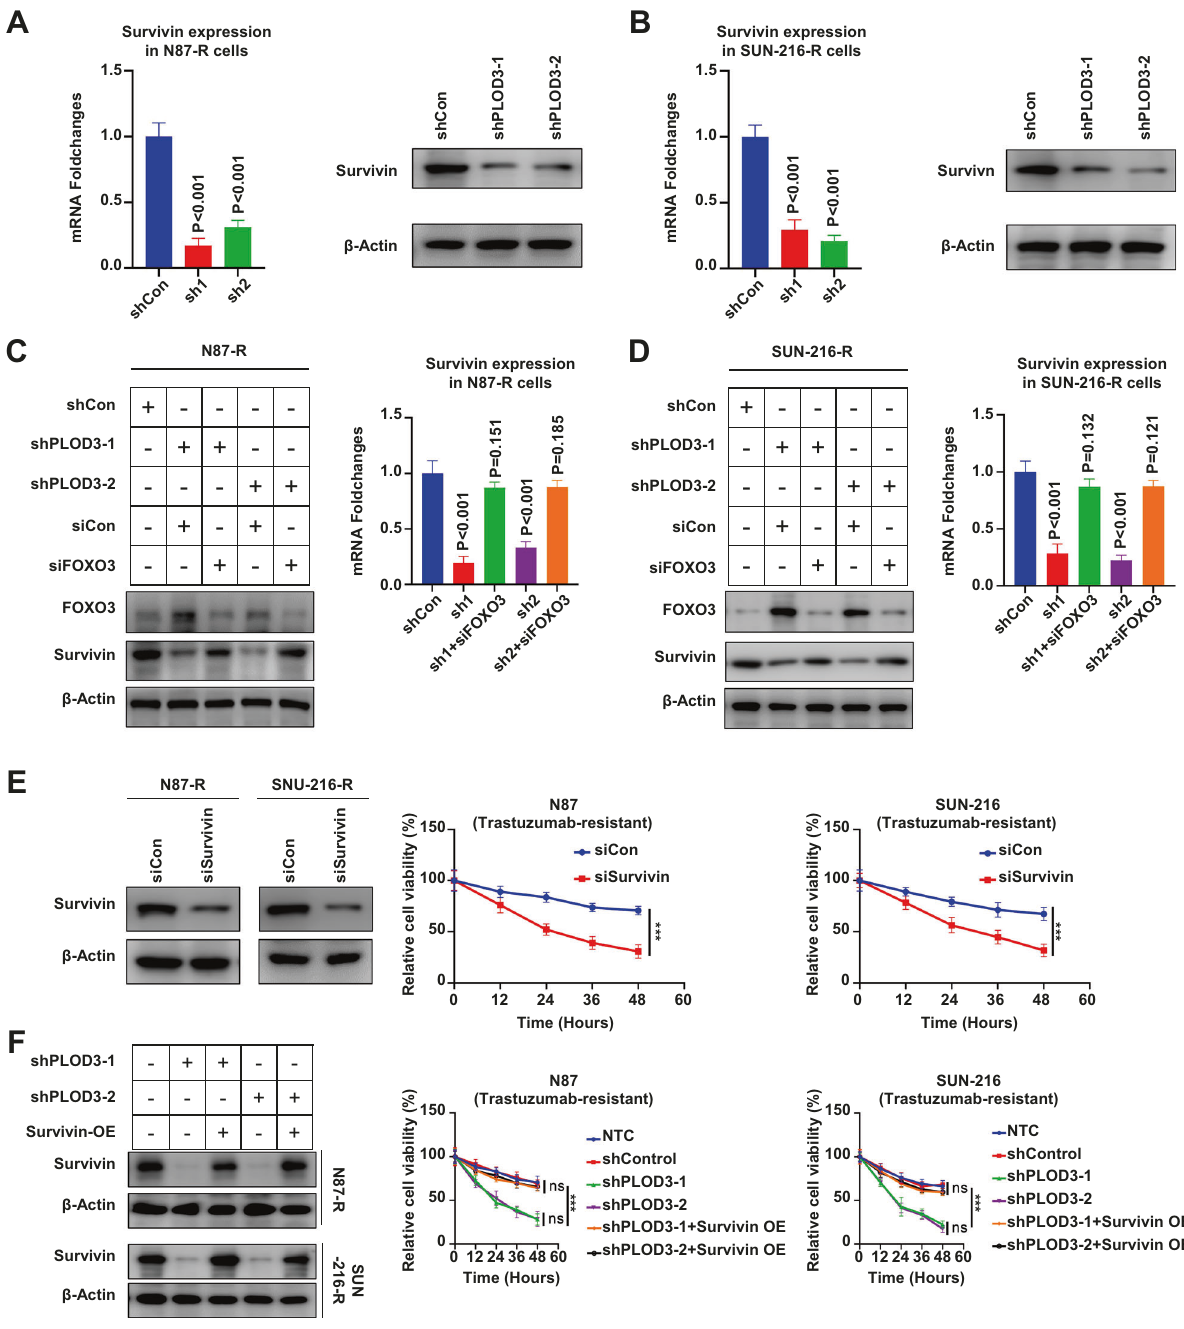
Fig. 7 The FOXO3-Survivin pathway plays a crucial role in PLOD3-induced resistance to HER-2. A , B The mRNA and protein levels of Survivin after PLOD3 knockdown in Trastuzumab-resistant GC cell lines were validate by RT-PCR and western blot. C , D RT-PCR and immune blotting analysis showed that silencing FOXO3 in PLOD3-knockdown cells could restore Survivin expression. E MTT assays indicated suppression of Survivin expression in Trastuzumab-resistant GC cells could resulted in sensitization towards Trastuzumab. F Trastuzumab- resistant potential could be restored by overexpressing Survivin in PLOD3-knockdown GC cells according to MTT